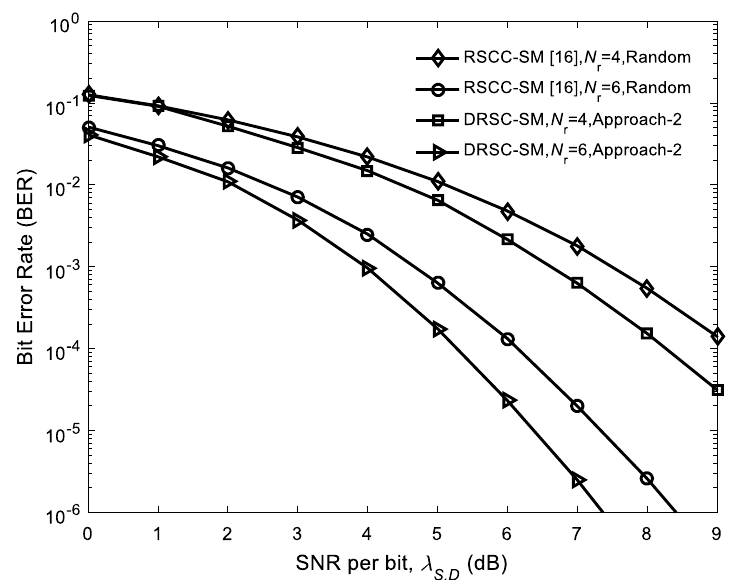
Fig. 17 BER performance of DRSC-SM and RSCC-SM schemes employing RS 1 ( 63,51 ) and RS 2 ( 63,31 ) . The solid line with diamond mark demonstrates the BER performance of RSCC-SM scheme with random selection pattern under N r = 4 . The solid line with circle mark demonstrates the BER performance of RSCC-SM scheme with random selection pattern under N r = 6 . The solid line with square mark demonstrates the BER performance of DRSC-SM scheme with Approach 2 under N r = 4 . The solid line with right triangle mark demonstrates the BER performance of DRSC-SM scheme with Approach 2 under N r = 6